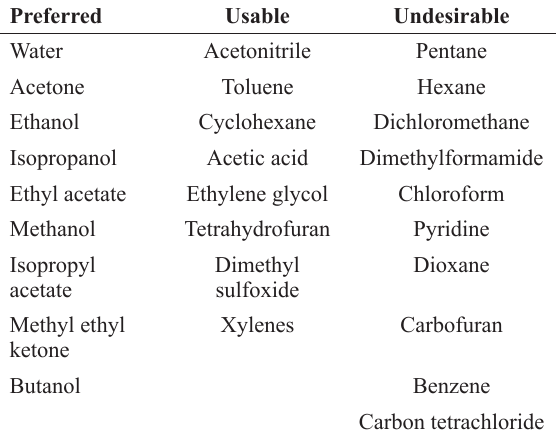
Solvent selection guide for green eluents for LC separations. Adapted from Alfonsi et al.